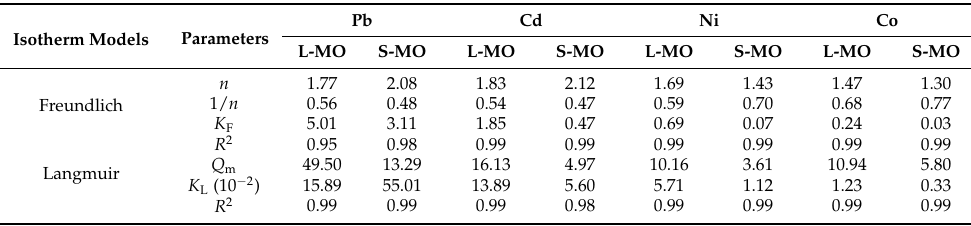
Figure 6. Sorption isotherms of ( a ) Pb(II); ( b ) Cd(II); ( c ) Ni(II); and ( d ) Co(II) onto L-MO and S-MO. Table 2. Freundlich and Langmuir parameters for the sorption of Pb(II), Cd(II), Ni(II), and Co(II) by Leaves and seeds of Moringa oilefera.